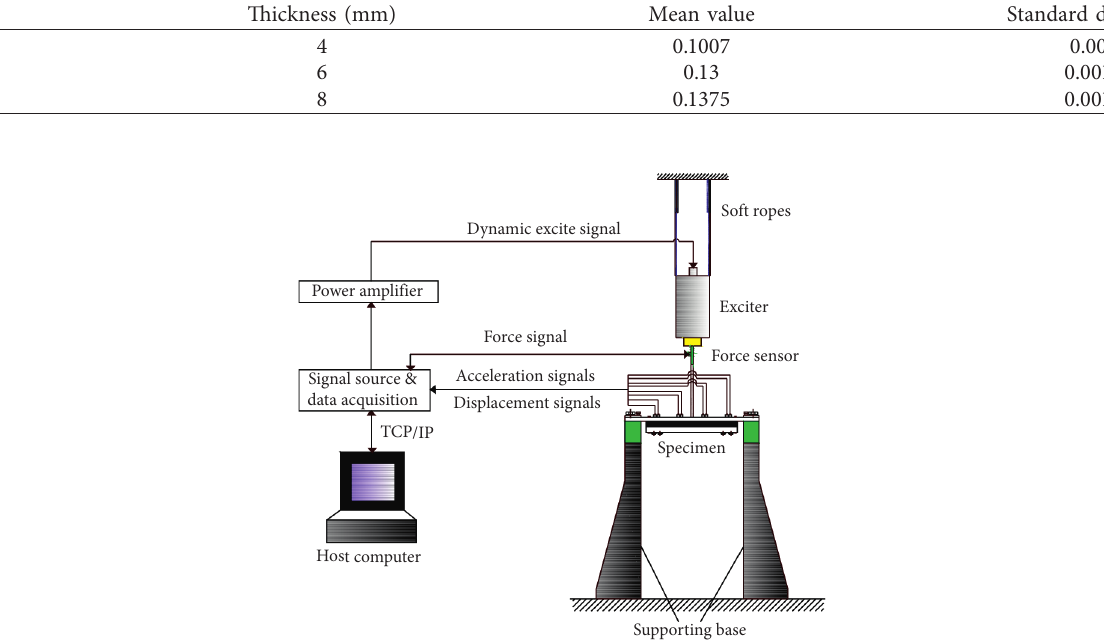
Figure 8: Schematic of the modal test system.